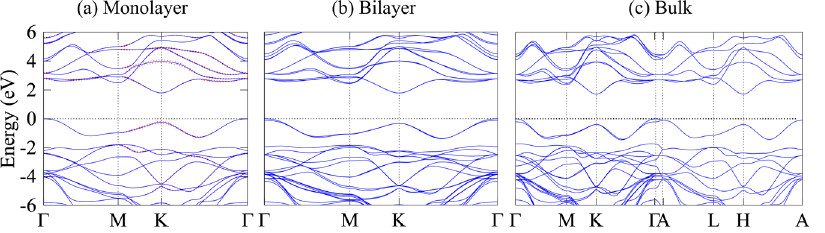
Fig. 2 DFT-PBE calculated band structures for MoSi 2 N 4 from monolayer to bulk. The blue solid and red dotted lines in ( a ) represent the band structure without and with SOC effects for monolayer MoSi 2 N 4 , respectively. Table 2. Interlayer chemical coupling effects on the band gap of MoSi 2 N 4 compared with other layered